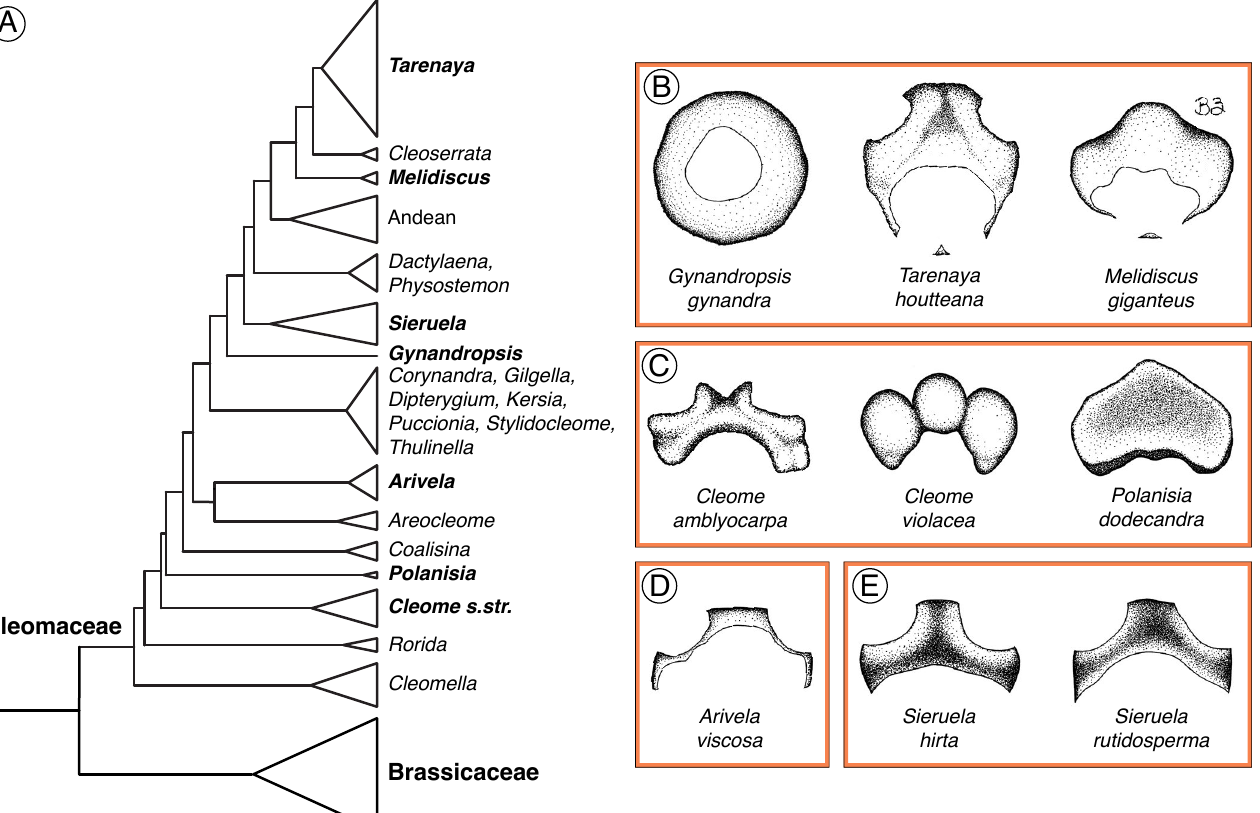
Figure 12. Cleomaceae phylogeny and floral nectaries of the nine species grouped by shape and position. ( A ) Cleomaceae phylogenetic tree derived from that of Patchell et al. (2014) and Bayat et al. (2018) [7,22] with clades sampled here bolded. ( B ) Annular nectaries. ( C ) Protruding adaxial nectaries. ( D ) Slightly convex adaxial nectary. ( E ) Concave adaxial nectaries. Illustrations depict the apical view of the nectary with stippling to represent more basal or concave regions. Nectary size varies between species; illustrations are not to the same